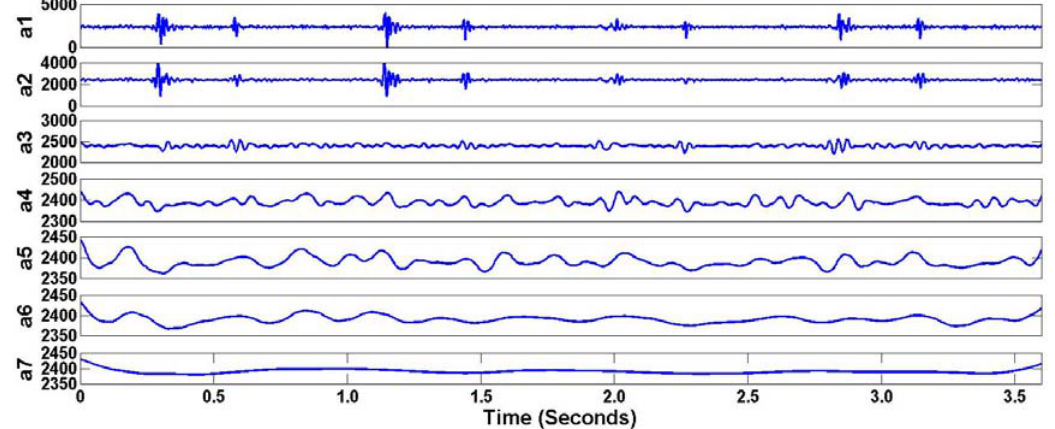
Figure 10. Seven Approximation Coefficients (a1–a7) of Heart Sounds using Daubechies Wavelet.